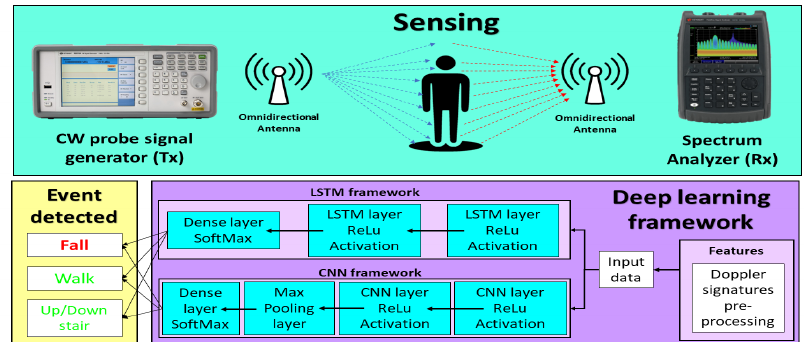
Figure 1. Overview of the fall detection system based on Doppler